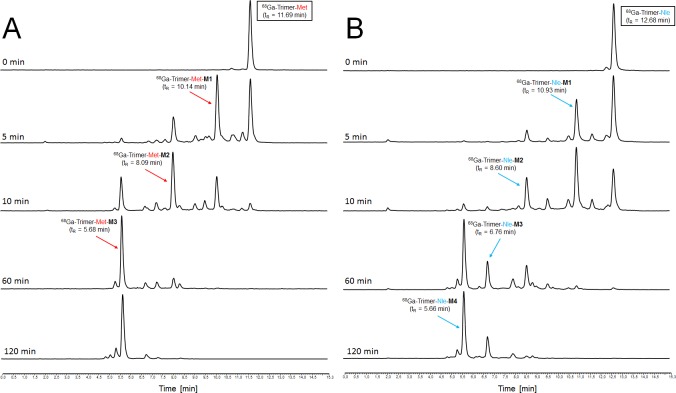
In vitro metabolite assessment of 68Ga-labelled trimers by artificial enzymatic degradation.Representative radio-RP-HPLC chromatograms of enzymatic degradation of 68Ga-labelled trimeric Met- (A) and Nle (B) conjugates in vitro (major metabolite formation assigned with arrows).